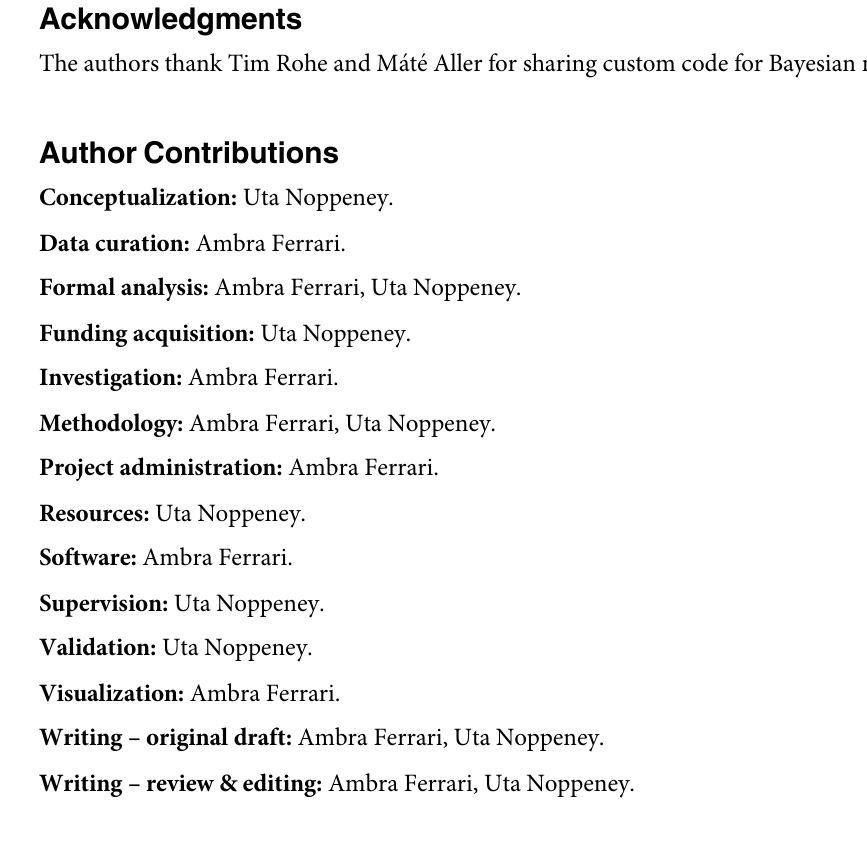
S1 Fig. fMRI results of unisensory auditory localisation inside the scanner. (a) Experimen- tal procedure: after each sound presentation, participants reported their perceived auditory location via button press with the correspondent key. (b) Increases of BOLD response for lateralised right versus left sounds (blue) and vice versa (orange) are rendered on an inflated canonical brain ( p < 0.001 uncorrected at peak level for visualisation purposes, extent thresh- old k > 0 voxels). Bar plots represent across participants’ mean ( ± SEM) parameter estimates in nondimensional units (corresponding to percentage whole-brain mean) from left (x = − 50, y = − 32, z = 8) and right (x = 52, y = − 22, z = 4) plana temporalia. The data used to make this figure are available in S3 Data. C, centre; L, left; R, right. S2 Fig. Distributions of spatial estimates in the fMRI experiment. The distribution of spatial estimates (across participants’ mean) given by observers’ behavioural localisation responses (solid lines) or predicted by the BCI model with attentional effects (i.e., “BCI model, Att free”) fitted to observers’ behavioural responses (dashed lines) are shown across all conditions in our a 3 (auditory location) × 3 (visual location) × 2 (prestimulus attention: auditory, visual) × 2 (poststimulus report: auditory, visual) factorial design. The data used to make this figure are available in S2 Data. BCI, Bayesian causal